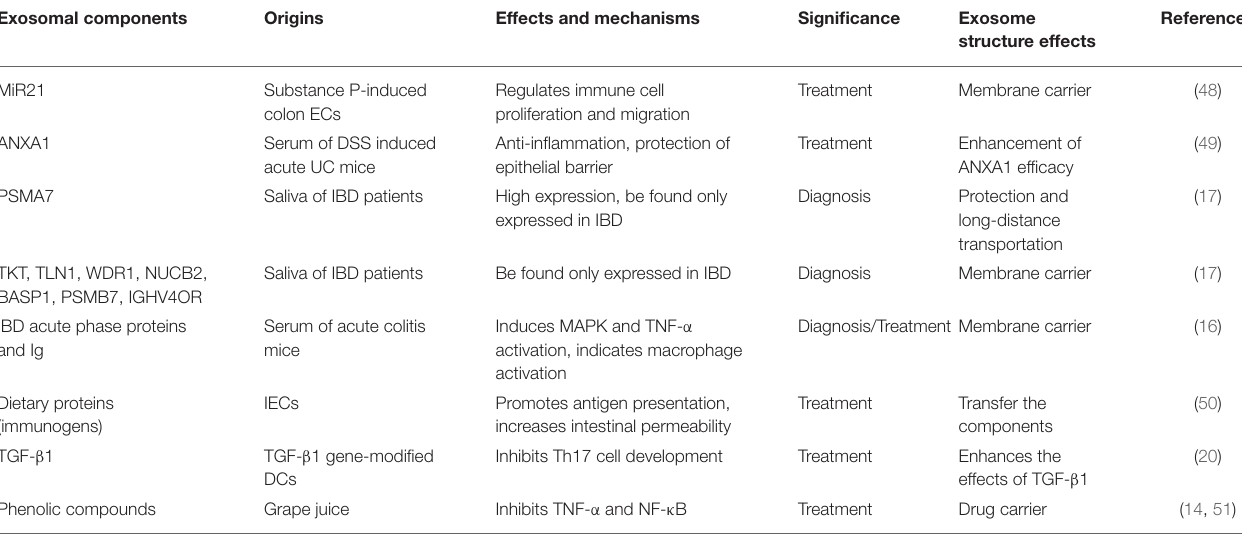
TABLE 1 | Effects of exosomes/exosomal components on